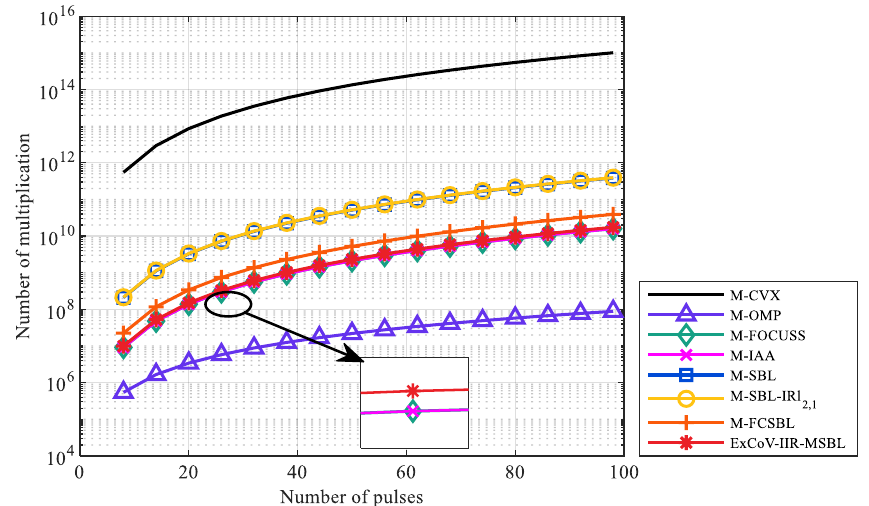
Figure 3. Computational complexity of different compared SR-STAP algorithms.